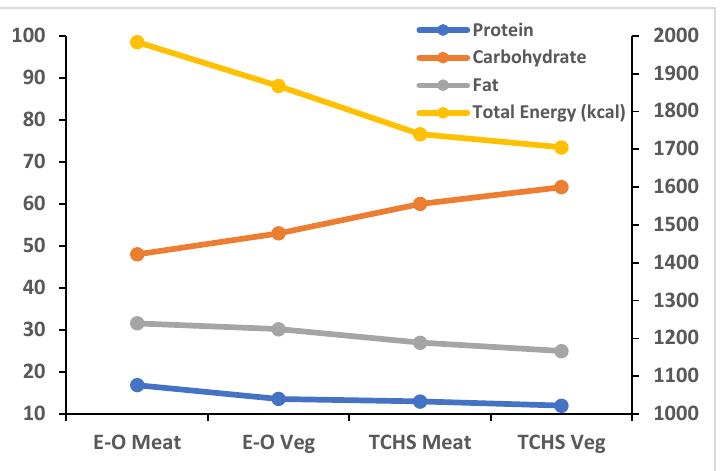
Figure 1. Comparison of the nutrient intakes in different diet groups of the EPIC-Oxford (E-O) and cohort 1 of the Taiwanese (TCHS) studies X-axis: Diet group; Y-axis (right): Total energy intake in kcal; Y-axis (left): Nutrient intake as percentage of total energy intake; Meat = Meat-eater; Veg = Vegetarian.